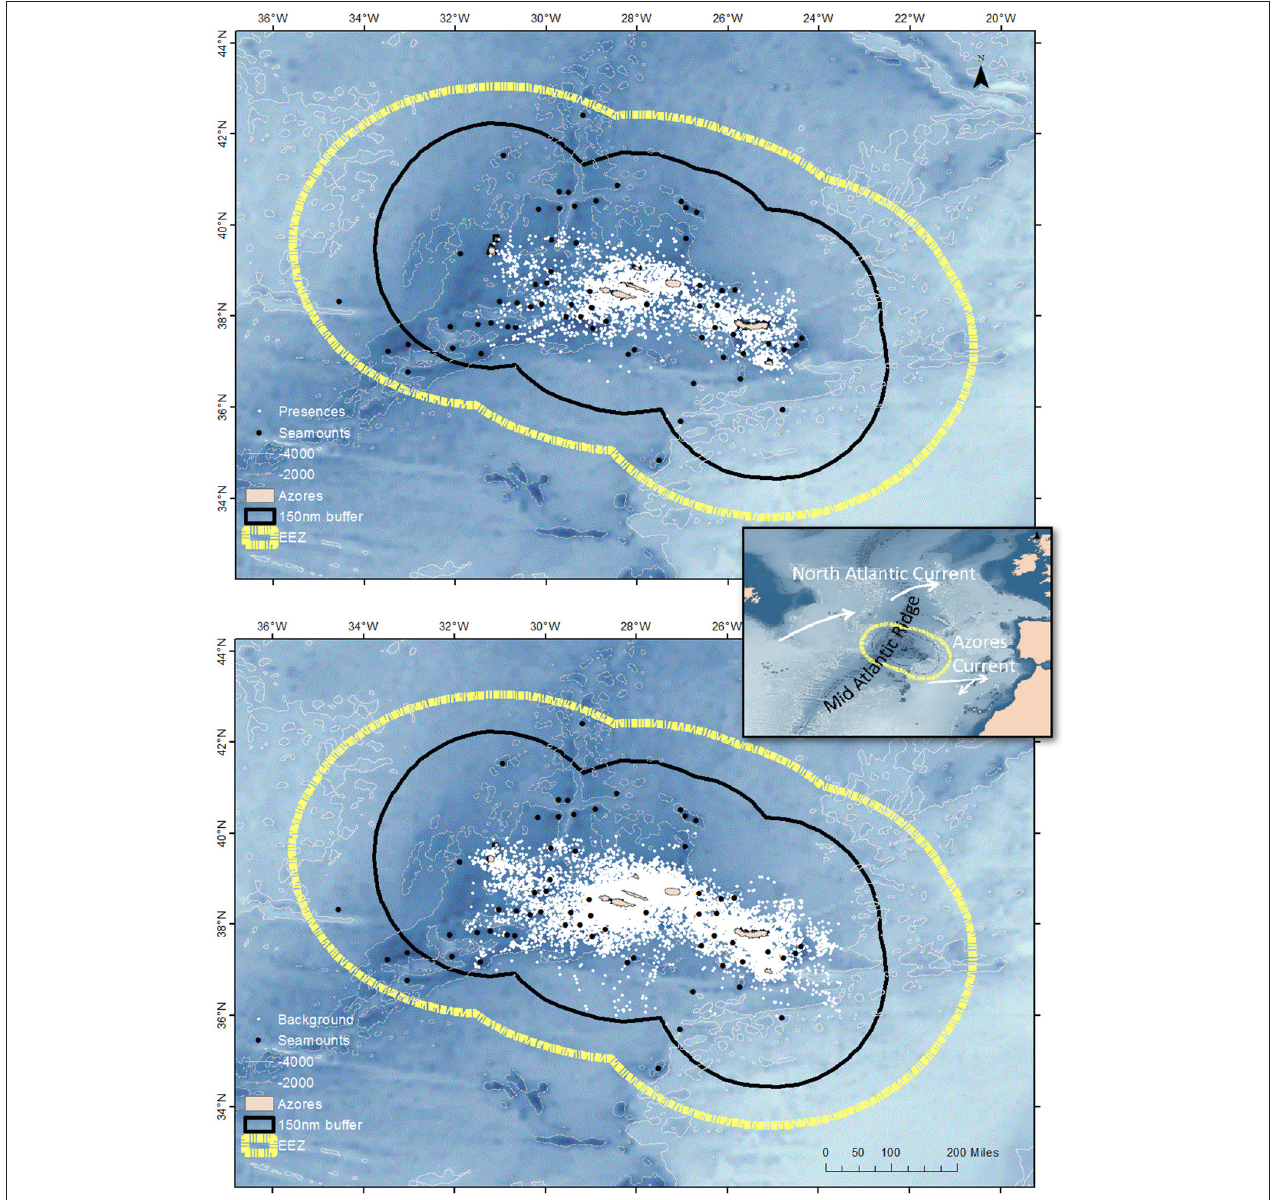
FIGURE 1 | Cetacean sighting positions (top panel) and environmental samples (lower panel) within the study region. The position of the Azores archipelago in the North Atlantic and the main oceanographic structures mentioned in the text are show in the inset. The yellow stippled line represents the limit of the 200 nautical miles economic exclusive zone (EEZ) and the thin black line represents the limit of the 150 nautical miles buffer applied to the predictions from the MaxEnt models. Bathymetry is shown as a scale of blue; the 2000 and 4000m isolines are also shown. Large seamounts are shown as black dots; smaller seamount-like features are not